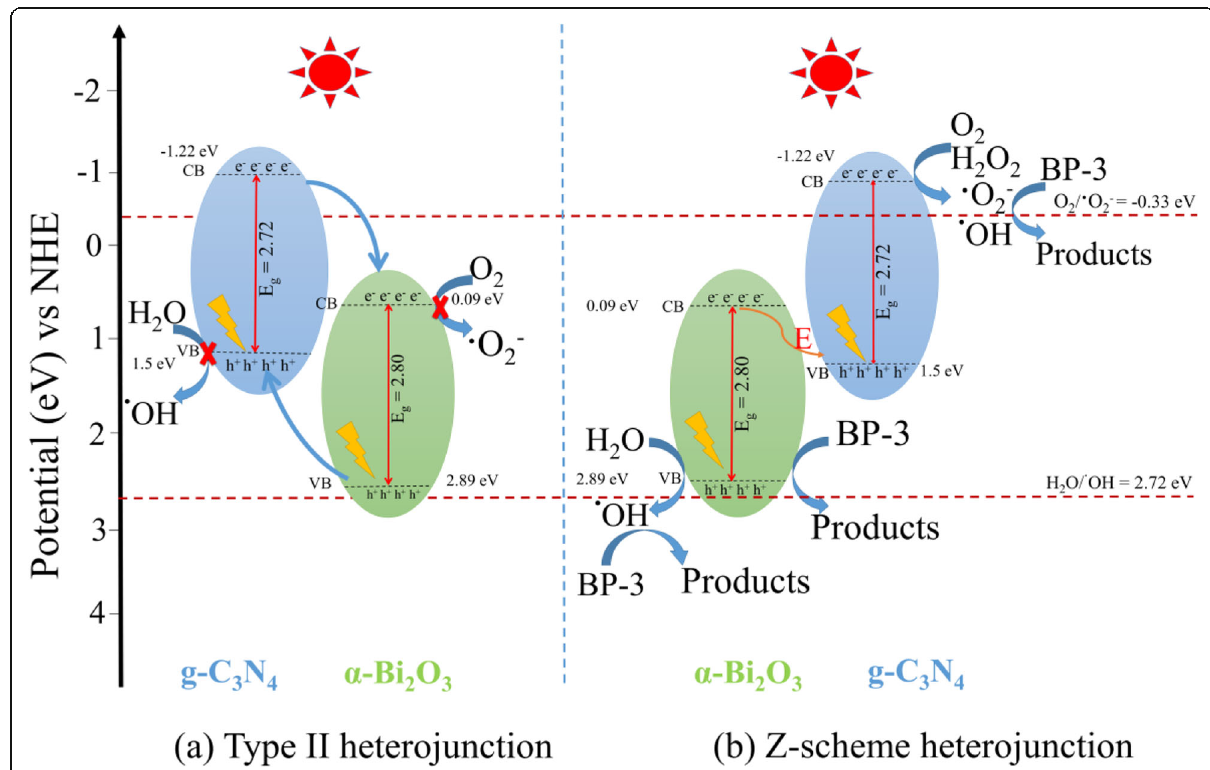
Fig. 11 Schematic illustration of the possible electron – hole pair separation and photocatalytic mechanism of the α -Bi 2 O 3 @g-C 3 N 4 composite ( a ) Type II heterojunction; ( b ) Z-scheme